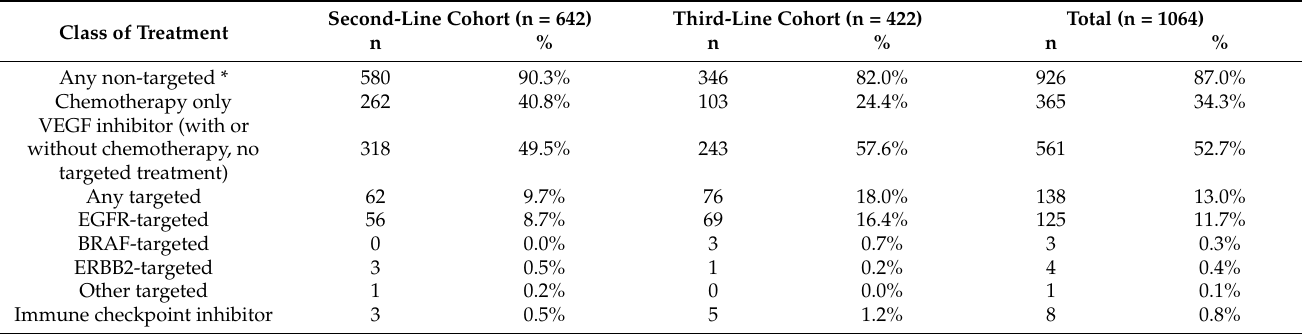
Table 1. Treatments immediately prior to ctDNA